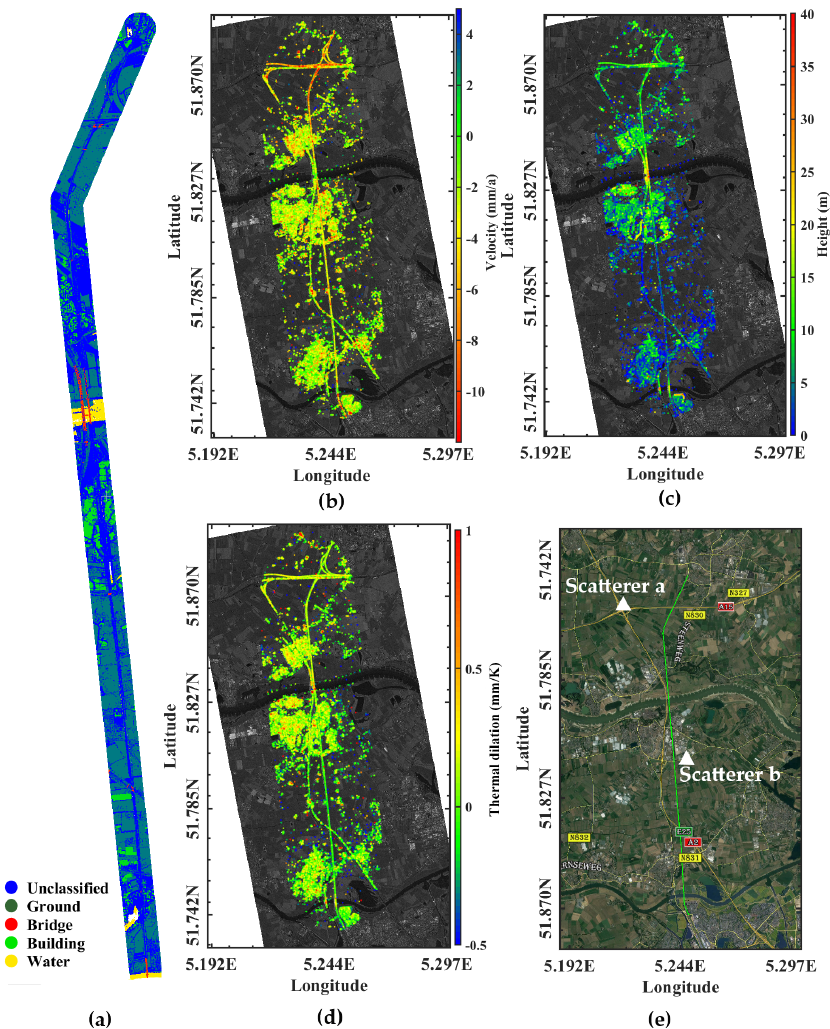
Figure 2. ( a ) AHN3 point cloud along the railway and its buffer zone with classifications. Estimated parameters on both CCS and TCS: ( b ) velocity map; ( c ) height map; ( d ) thermal dilation; and map. ( e ) Location of the railway (green